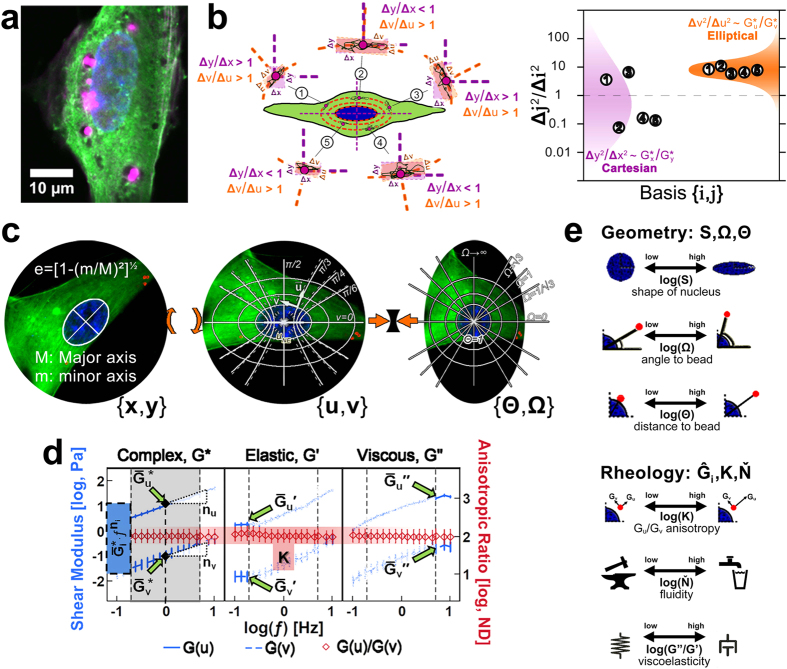
A nucleus-centered elliptical coordinate system for perinuclear cytoskeleton (pnCSK) rheology.(a) Four-channel laser confocal microscopy of paraformaldehyde-fixed hASCs on fibronectin-coated coverslip cultures expressing an eGFP-actin fusion protein (green). Cells contain intracellular AlexaFluor 568-tagged beads (1-μm diameter, red) delivered by lipid-based endocytosis in culture. After fixation, cells were stained with Hoechst 33342 (blue) and phalloidin-AlexaFluor 633 (magenta) to highlight localization of nucleus and F-actin fibers, respectively. (b) Representative cell diagram depicting differences observed in dispersion of anisotropic mean squared displacements ≪Δr2(τ)≫ measured using either rectangular coordinates {x, y} or curvilinear nucleus-centered elliptical coordinates {u, v}. (c) Nondimensional parameterization of intracellular bead position in nucleus-centered elliptical coordinates. Bead coordinates are circularized relative to the nucleus of each cell by normalization to the locus uNE of its nuclear perimeter in elliptical coordinates; after normalization, nucleus-relative bead distances and angular pitch {Θ, Ω} are ensembled into a unified polar nondimensional map in which all nuclear perimeters trace along Θ = 1. (d) Parameterization of anisotropic intracellular rheology via a model power-law rheology model  = ƒni for i = {u, v}. Complex shear moduli  and  are decomposed into their elastic and viscous terms G′ and G″. In the frequency range 0.2 Hz < ƒP < 5 Hz (i.e. −0.7 < log (ƒP) < 0.7, where ƒP is the power-law frequency span) anisotropic rheology exhibits constant flow behavior indices nu = nv, constant damping ratio G″/G′ = tan[α∙π/2], and constant ratio between flow consistency indices K = ; outside ƒP , intracellular rheology displayed constant Gi′ for ƒ < 0.2 Hz and constant Gi″ for ƒ > 5 Hz. Altogether, , ni and G″/G′ within ƒP for i = {u, v} in conjunction with moduli Gi′(ƒ < 0.2 Hz) and Gi″(ƒ > 5 Hz) suffice to recapitulate anisotropic cytoplasmic rheology in curvilinear elliptical coordinates. (e) Geometric (S, Ω, Θ) and rheological (K, Ň, G″/G′) nondimensional parameters derived from elliptical coordinate characterization of intracellular mechanics shown in (c,d).